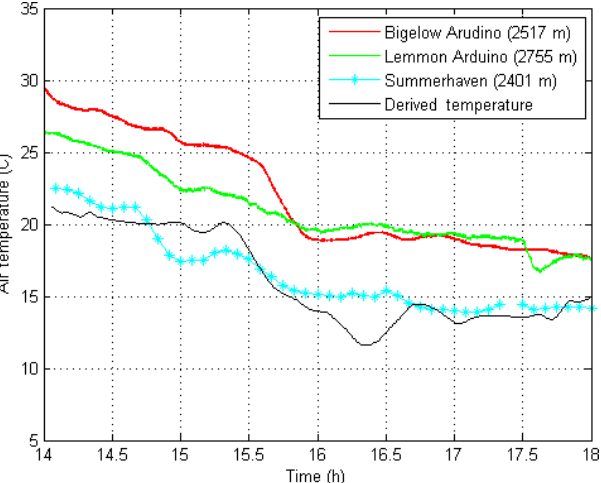
Figure 4. Observed and derived air temperatures during the ATOMMS ground-based